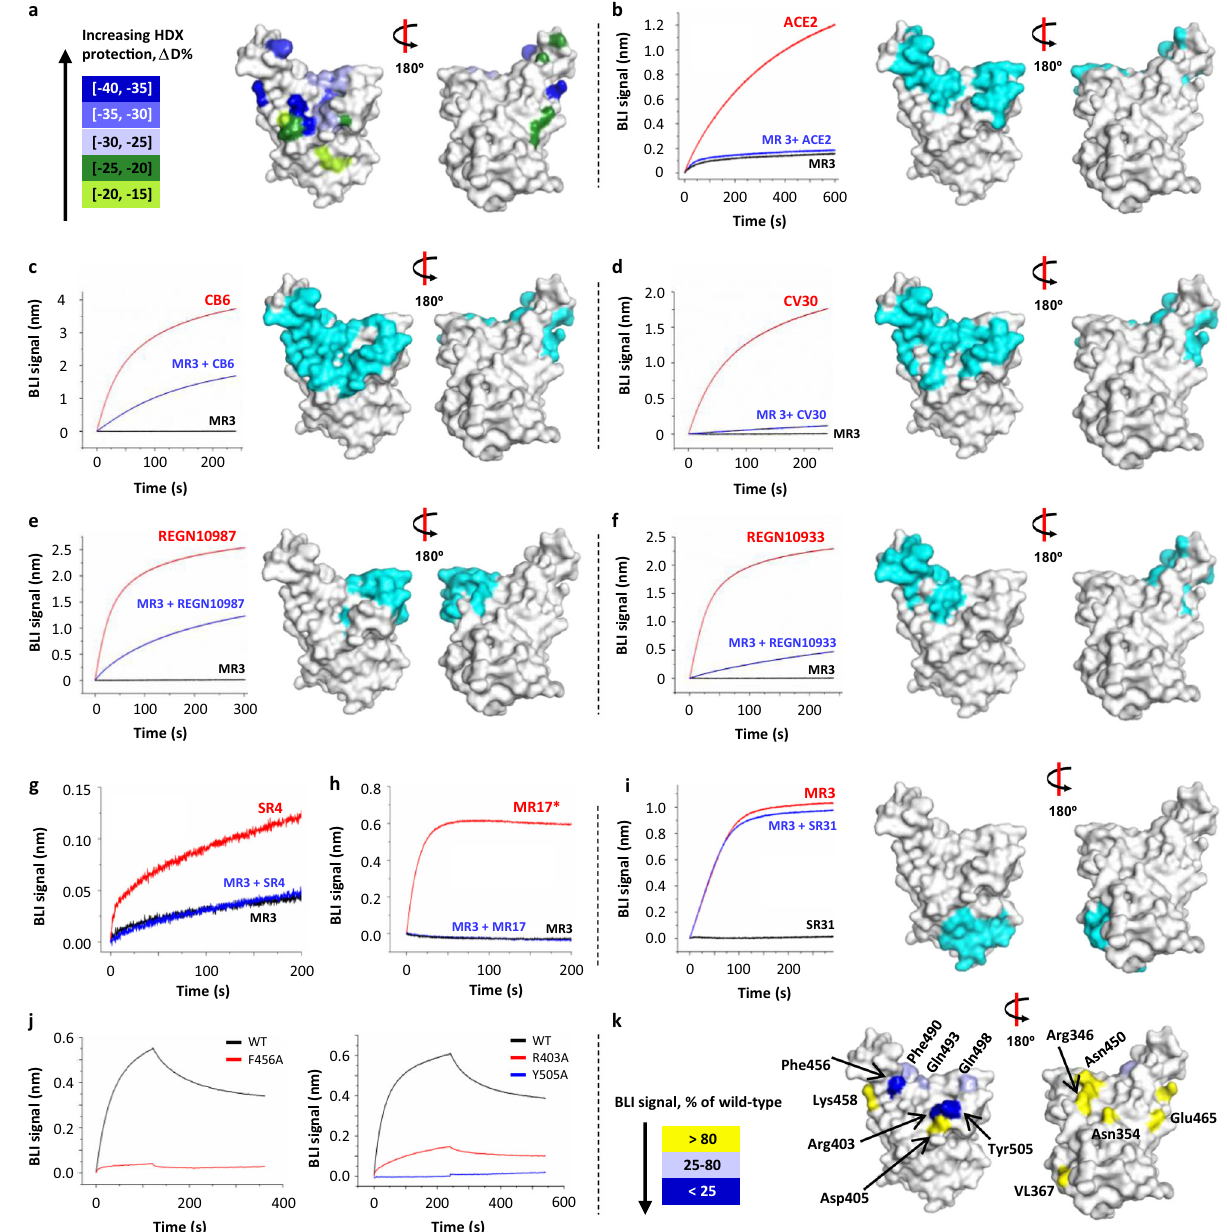
Fig. 3 HDX-MS, binding, and mutagenesis studies suggest an overlap between the MR3 epitope and RBM. a Epitope mapping using HDX-MS. RBD residues are color-coded based on the extent of the solvent exchange as an indication of protection by MR3-binding. b MR3 competes with ACE2 for RBD binding. The RBM surface is highlighted in cyan. c – h MR3 competes with RBM-targeting antibodies for RBD binding. They include monoclonal antibodies CB6 35 ( c ), CV30 36 ( d ), REGN10987 12 ( e ), REGN10933 12 ( f ), and the two sybodies SR4 ( g ) and MR17 ( h ) characterized in this study. i The MR3-RBD binding is compatible with SR31, which targets a non-RBM surface 37 . In c – h , the epitopes of the antibodies are highlighted in cyan except for SR4 and MR17, which are shown in Fig. 1c, e. In b – h , binding assays were performed using RBD immobilized on a sensor. BLI pro fi les were recorded with (black and blue) or without (red) pre-saturation of MR3 using the indicated antibodies as analytes. The assays in i were performed as in b – h except that SR31 was used for pre-saturation. j Three RBD mutations (red and blue) with severely impaired MR3 binding compared with the wild type (WT, black). The data for the rest of the 10 mutants are in Supplementary Fig. 9. k Mapping the mutagenesis data to the RBD structure. Residues are colored based on the sensitivity to alanine mutation; mutants showing <80% binding signal compared to the wild type are considered to be involved in binding, assuming no allosteric effects. Source data for b – j are provided as a Source data fi le. ACE2 angiotensin-converting enzyme 2, BLI biolayer interferometry, HDX-MS hydrogen – deuterium exchange mass spectrometry, RBD receptor-binding domain, RBM receptor-binding